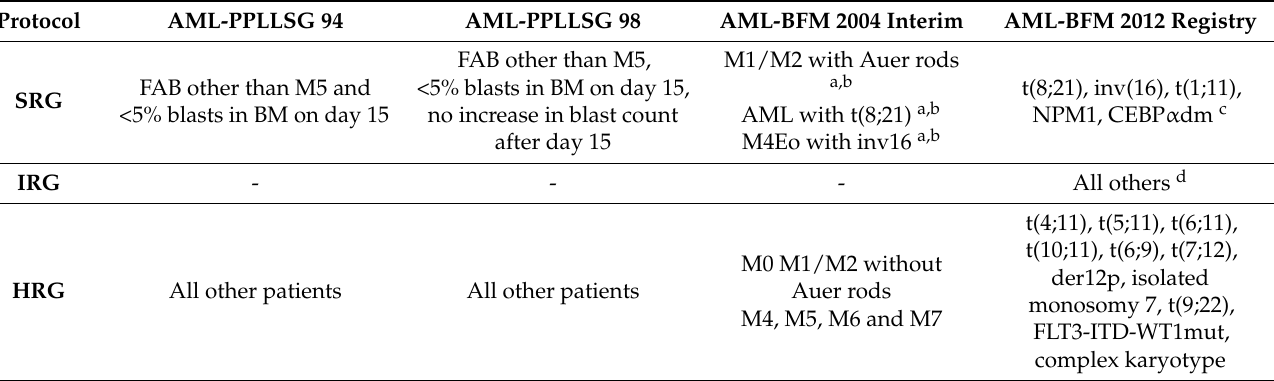
Table 3. Stratification to the risk